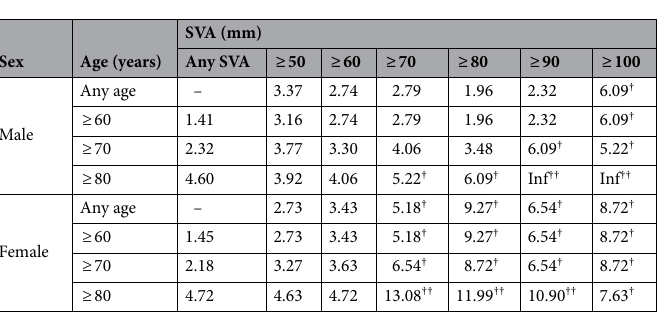
Table 3. Positive likelihood ratio matrix for mild cognitive impairment prediction. Values indicate positive likelihood ratios for the combination of age and SVA. Ratios ≥ 5 † and ≥ 10 †† are indicated. SVA sagittal vertical axis, Inf